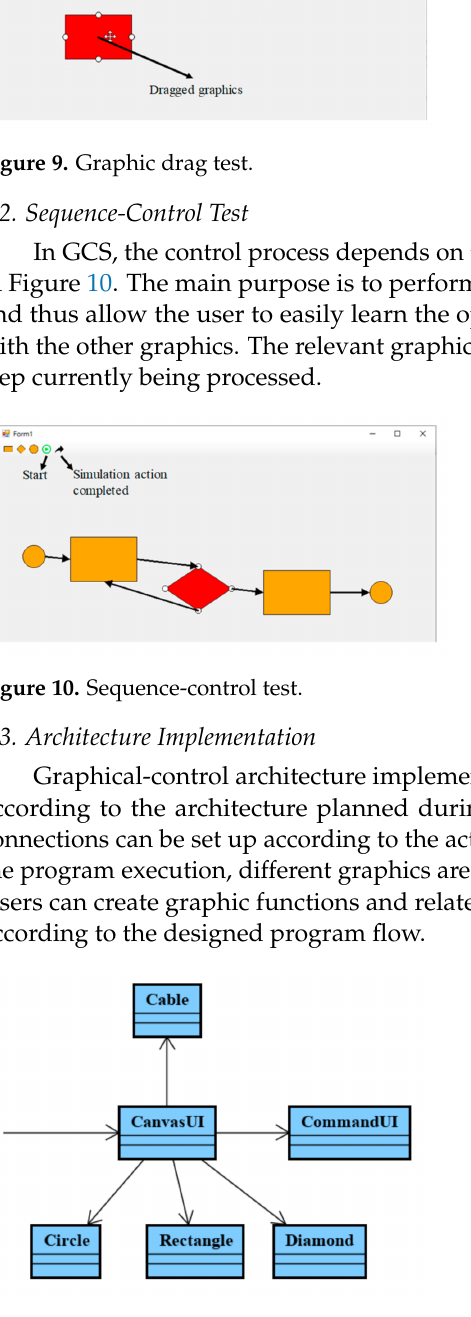
Figure 11. Graphical-control architecture during the design